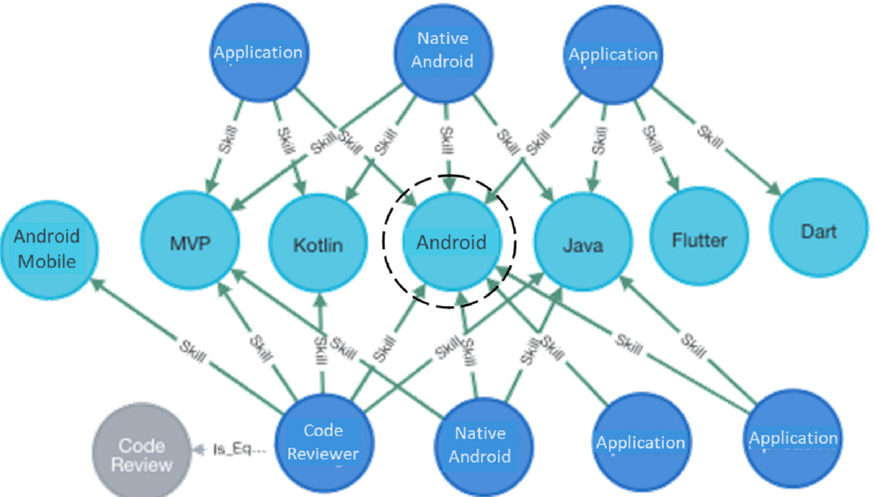
Figure 10. (Partial) knowledge graph for skills associated with Android mobile application devel-